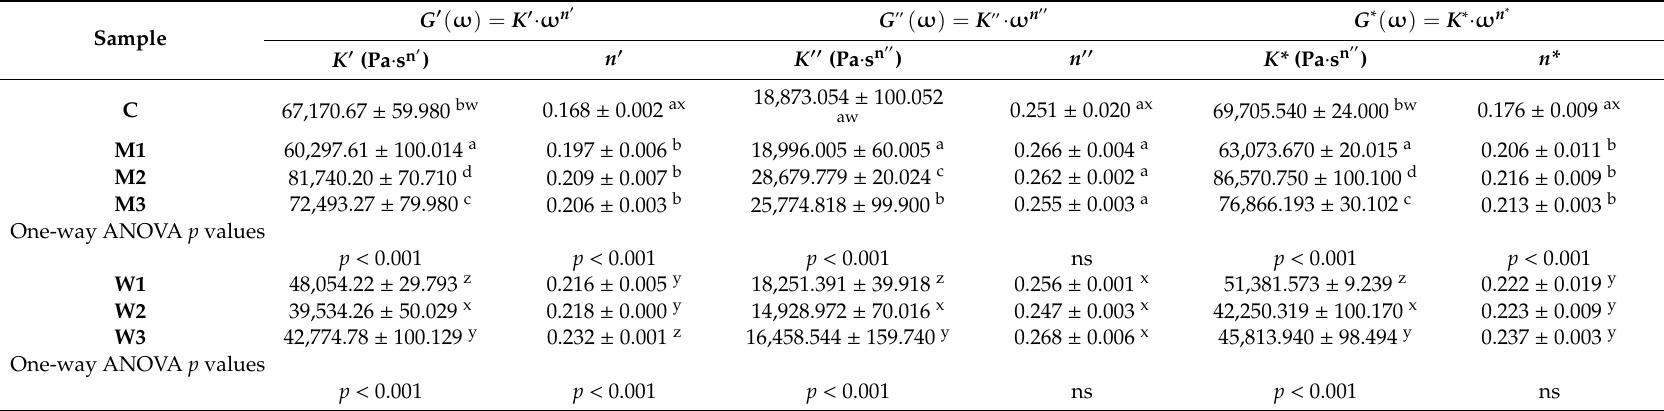
Table 1. Power law models parameters describing the dependence of storage, loss and complex moduli on